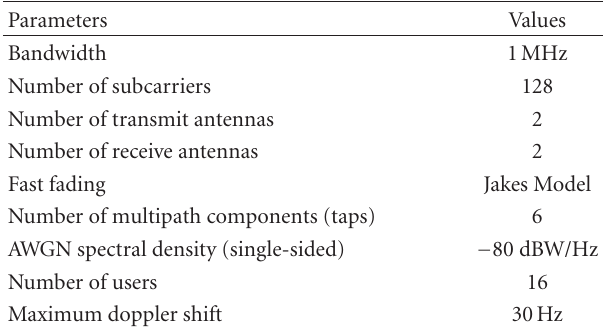
Table 2: Simulation